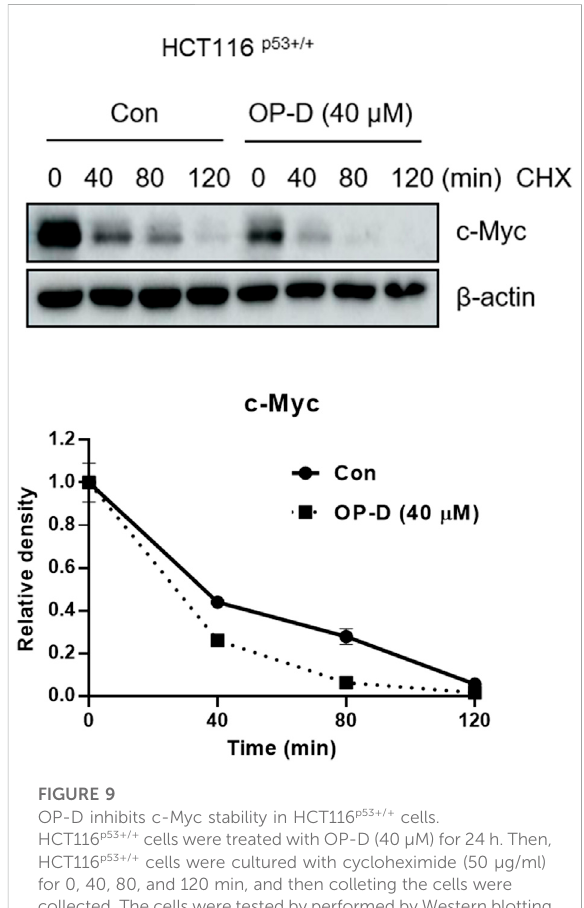
FIGURE 9 OP-D inhibits c-Myc stability in HCT116 p53+/+ cells. HCT116 p53+/+ cells were treated with OP-D (40 μ M) for 24 h. Then, HCT116 p53+/+ cells were cultured with cycloheximide (50 μ g/ml) for 0, 40, 80, and 120 min, and then colleting the cells were collected. The cells were tested by performed by Western blotting with antibodies of c-Myc and β –